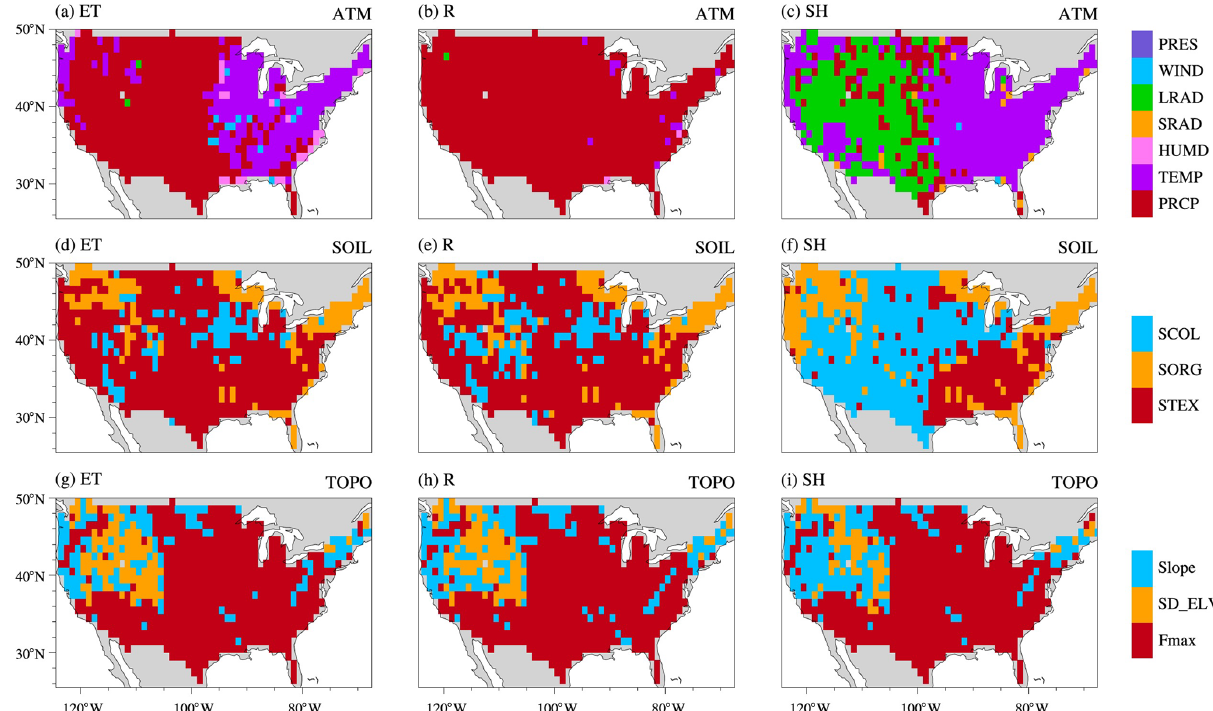
Figure 7. The largest induced spatial variability for the annual climatological mean of ET (a, d, g) , R (b, e, h) , and SH (c, f, i) induced by each component of ATM (a–c) , SOIL (d–f) , and TOPO (g–i) .